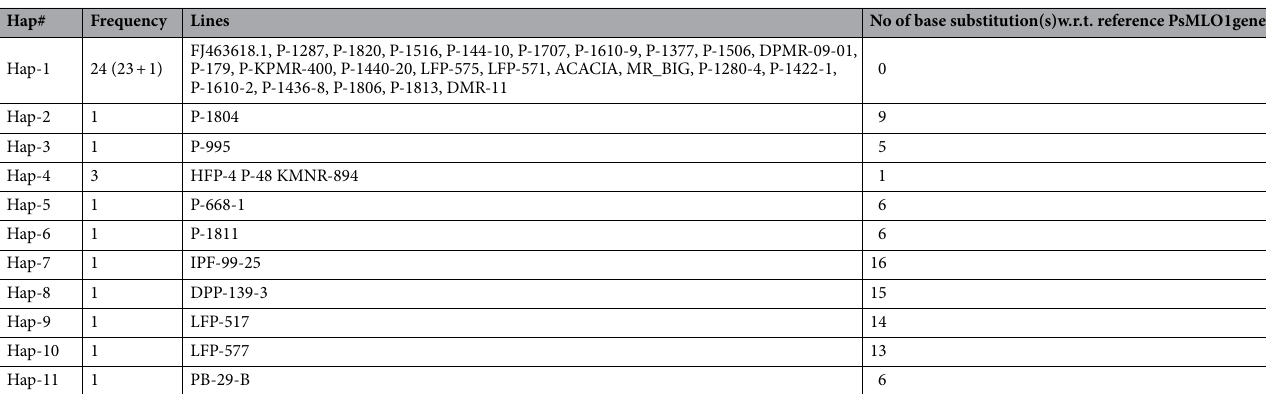
Table 4. Frequency distribution of different PsMLO1 haplotypes detected amongst the resistant pea